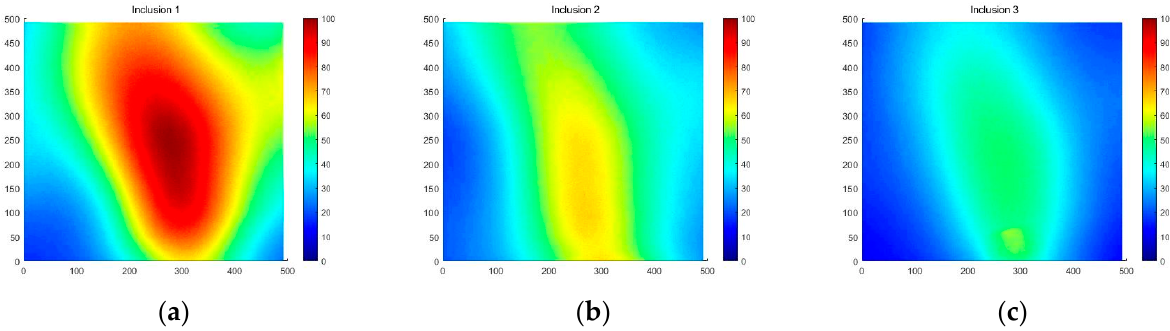
Figure 25. Two-dimensional colormap simulation according to depth: ( a ) 3 mm, ( b ) 5 mm, ( c ) 7 mm.